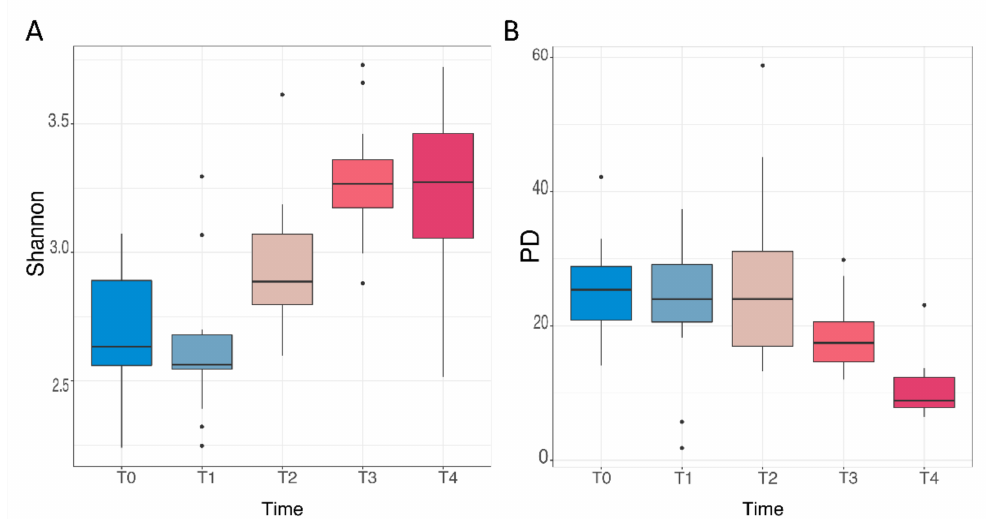
Figure 2. Alpha diversity distribution box plots. In ( A ): Shannon diversity index (SDI) estimated for each time point. In ( B ): Faith’s phylogenetic distance (PD) estimated for each time point. (Number of mice: T1 n = 14, T2 n = 12, T3 n =14, and T4 n